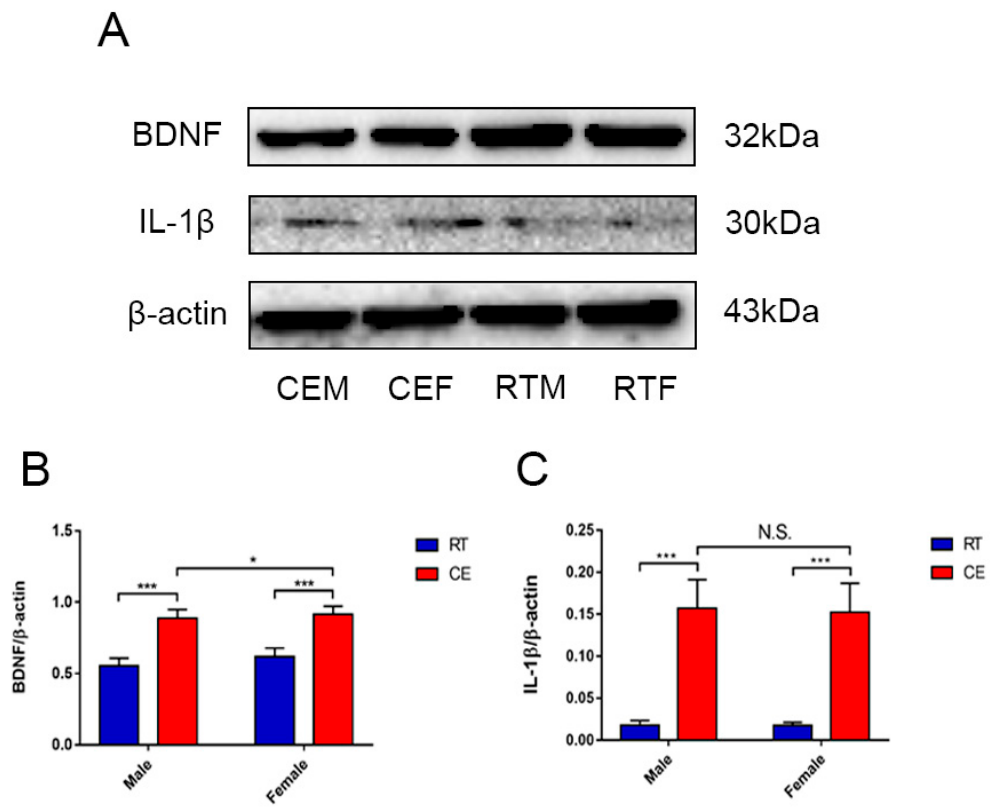
Figure 5. Neurotrophin and inflammatory cytokine expression in the hippocampus of cold-stressed mice. ( A ) Brain-derived neurotrophic factor (BDNF), interleukin (IL)-1 β , and β -actin levels were evaluated by western blotting and quantified by densitometric analysis. ( B , C ) Quantification of expression levels based on BDNF / β -actin ( B ) and IL-1 β / β -actin ( C ) ratios. Di ff erences between room temperature male (RTM) and cold exposure male (CEM), room temperature female (RTF) and cold exposure female (CEF), and CEM and CEF groups were evaluated by two-way analysis of variance. Results are expressed as the mean ± SD ( n = 6) of four independent experiments. N.S.: not significant; * p < 0.05, *** p < 0.001.